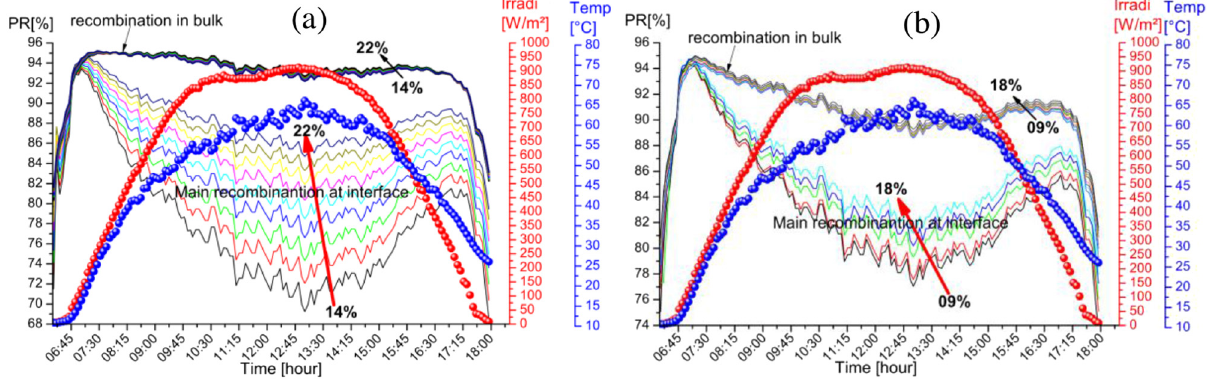
Fig. 6. Performance ratio of different ef fi ciency of CIGS modules (a) and silicon